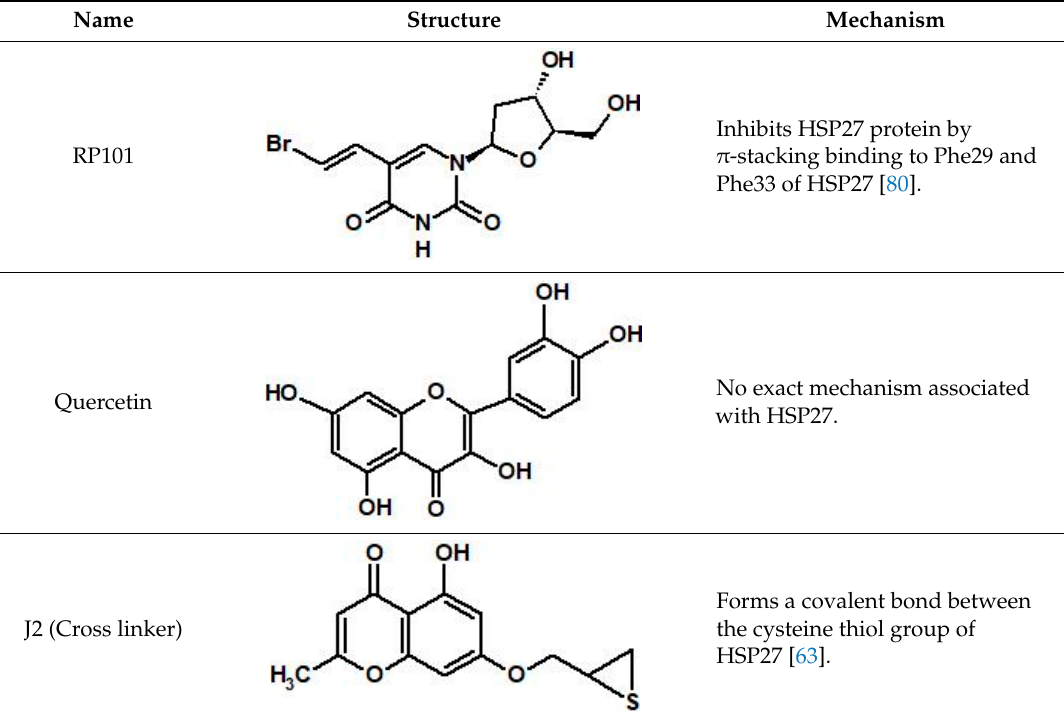
Figure 7. Altered cross-linking of heat shock protein 27 (HSP27) using small molecules for HSP27 inhibition. Scheme for the mechanism of HSP27-cross-linking by small molecules. Normal dimerization of HSP27 contributes to cancer cell survival, but abnormal dimerization of HSP27 using small molecules causes cancer cell death. Table 2. Structure and mechanism of action of small-molecule heat shock protein 27 (HSP27) inhibitors.